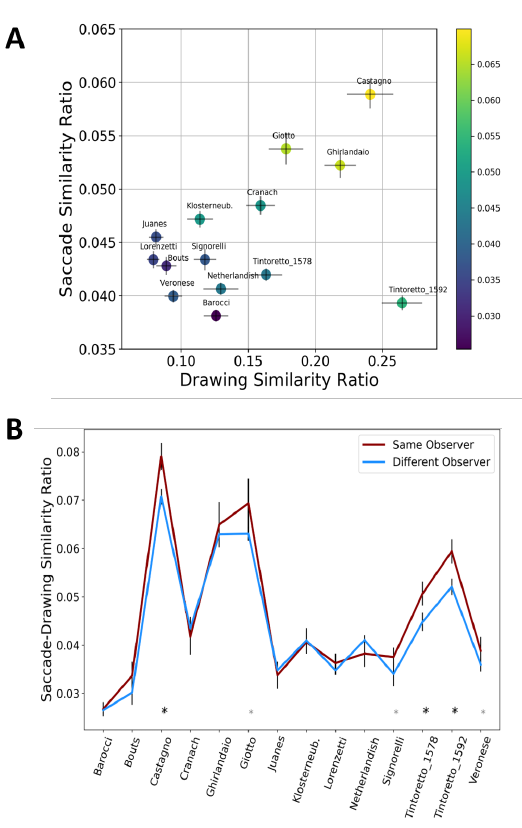
Figure 4. Similarity Measures by Painting. A) Drawing Var- iability (x-axis) and Saccade Variability (y-axis) only showed a weak correlation, but both measures are highly correlated with Drawing-Saccade similarity (yellow-highly similar, blue: not similar) (Error Bars: SEM). B) Saccade-Drawing similarity was higher for within observers (blue line) than across different ob- servers (brown line) ( * p <.05, * p <.01, Error Bars: SEM across